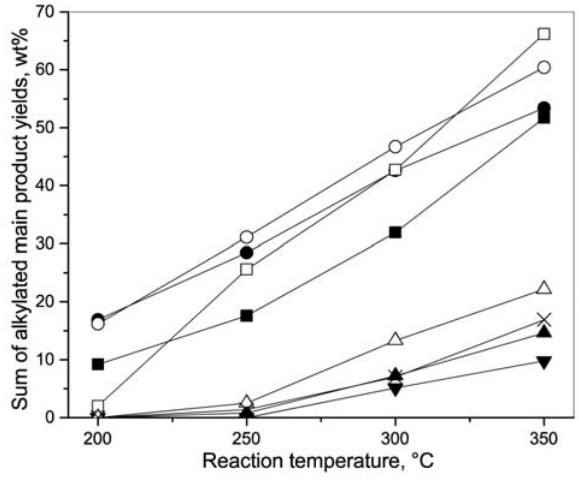
Figure 2. The sum of alkylated main product yields ( (cid:2) , (cid:3) , (cid:4) , (cid:5) ) and gaseous by-products ( (cid:2) , (cid:3) ,X, (cid:4) ) against the reaction tempe- rature over 5Pd,20K PO /AC ( (cid:2) , (cid:3) , (cid:3) , (cid:4) ) and 5Pd,20CsOH/AC 3 4 (solid) and He (open). (WHSV=1 g ( (cid:4) , (cid:5) , (cid:2) ,X) in H 2 p=21 bar; A/E=1:2 mol/mol)